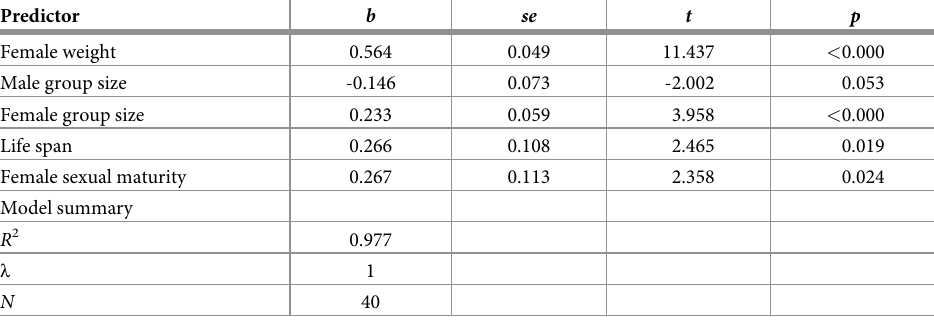
Table 2. The following model was selected with AIC for neocortex size as the dependent variable. Predictor b se p Female